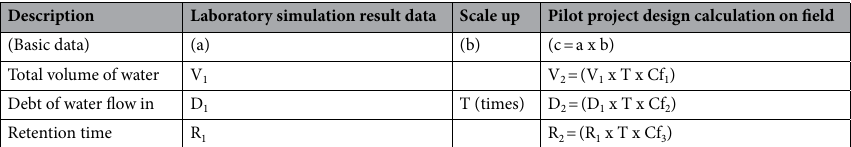
Table 5. Calculation scales up process reference with the basic data of Simulation Laboratory Experiment. Note: Cf 1 = correction factor (CF) for water volume; Cf2 = CF for water debt; Cf3 = CF for retention